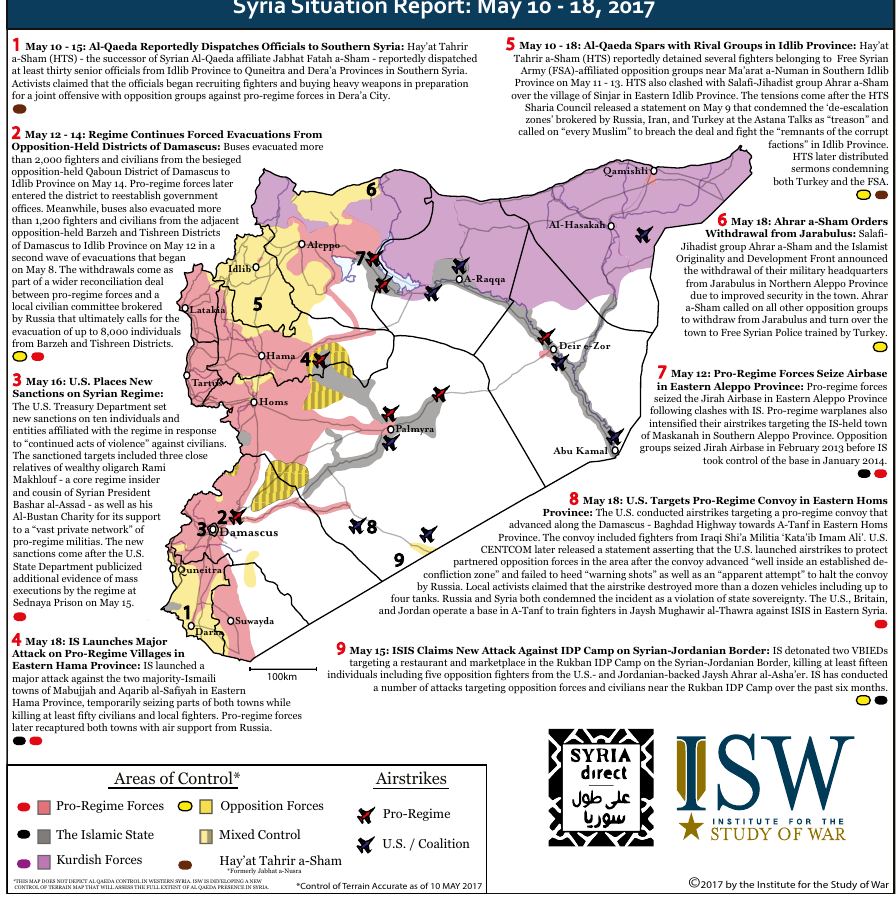
Fig. 1. Kurdish regions and controlling Northern border in Syria (source: Kozak